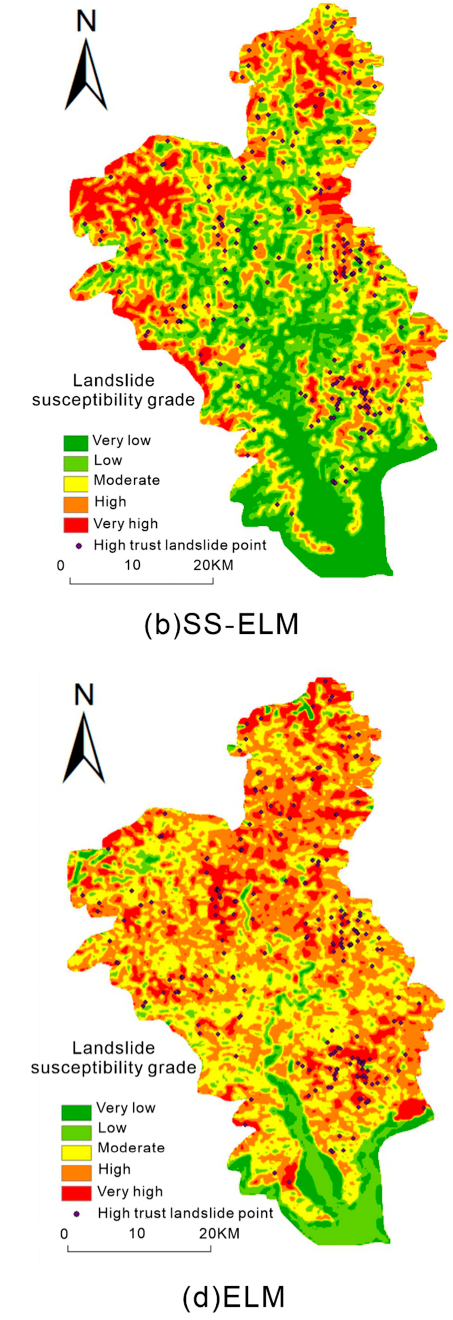
Figure 10. Landslide susceptibility